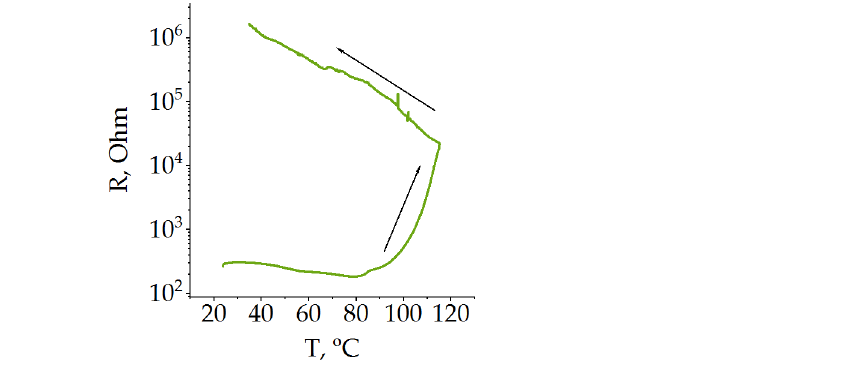
Figure 2. Change in resistance of poly[Ni(CH 3 OSalen)] during heating in 1 M LiTFSI EC/DEC.